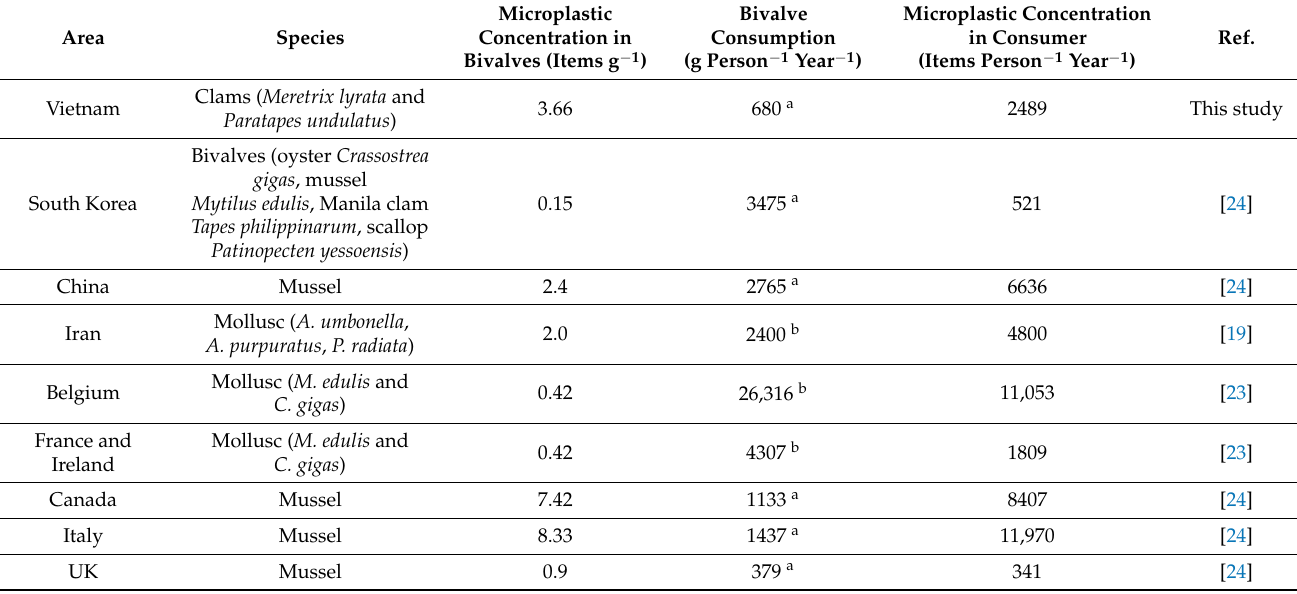
Table 3. Estimation of microplastic intake in consumers’ bodies from bivalve consumption in differ- ent